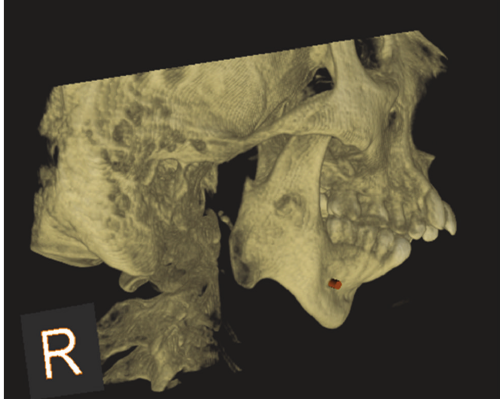
Figure 9: 3D CBCT right lateral shows absence of glenoid fossa and complete absence of the